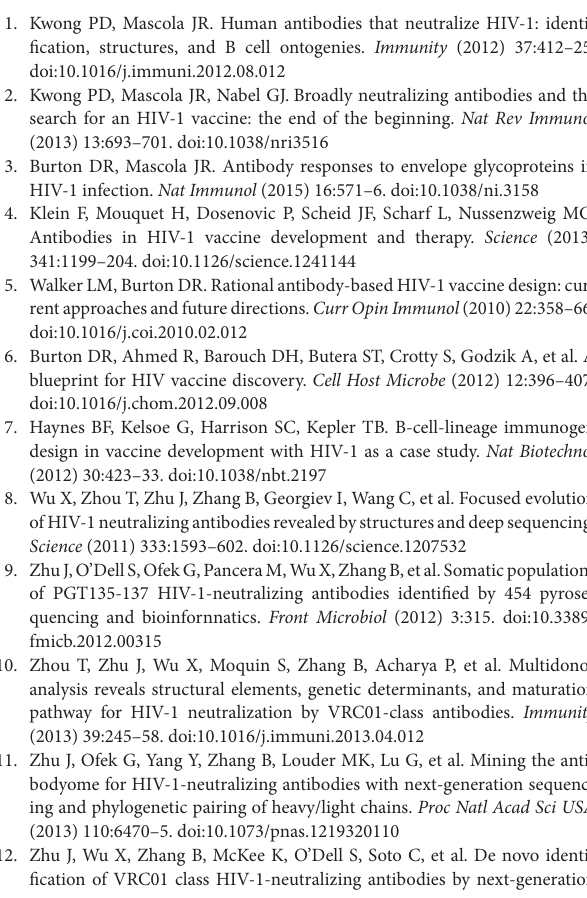
FigUre s3 | Ultra-deep sequencing of the donor-17 HC repertoire. (a) Distributions of germline gene usage (left), somatic hypermutation (middle), and HCDR3 length (right). In the histogram of germline gene family distribution, IgHV4 is highlighted in black whereas other germline genes are shown in gray (left 1). A more detailed distribution within the IgHV4 family is also plotted (left 2). (B) Identity-divergence analysis of the donor-17 HC repertoire using the PGT121- class bNAb HCs as templates. Sequences are plotted as a function of sequence identity to WT bNAb HCs and germline divergence. Color-coding indicates sequence density at a particular point on the 2D plot. Wild-type bNAb HCs are labeled on the 2D plots as black dots. Sequences with HCDR3 identity of 90% or greater and those assigned to IgHV4-61 are shown as orange dots and red asterisks, respectively, with the number of sequences for each labeled on the 2D plot. (c) Sequence alignment of selected HCs of the putative IgHV4-61 origin with respect to two germline genes (IgHV4-59 and IgHV4-61) and WT bNAb HCs. The three HCDR regions are marked above the sequences, with the mutations with respect to IgHV4-59 colored in red. Below the sequence alignment, asterisk (*) indicates identical residues, colon (:) indicates residues with strongly similar properties, and period (.) indicates residues with weakly similar properties. FigUre s4 | Digital panning of a diverse donor-17 single-chain variable fragment (scFv) library against a clade-C V1V2-ferritin nanoparticle. This scFv library, constructed from the donor-17 peripheral blood mononuclear cells (PBMCs) using a large set of primers, has been screened against a native-like gp140 trimer probe, gp140.664.R1-Avi-Biot. Distributions of germline gene usage (a) , somatic hypermutation (B) , and CDR3 loop length (c) are plotted for